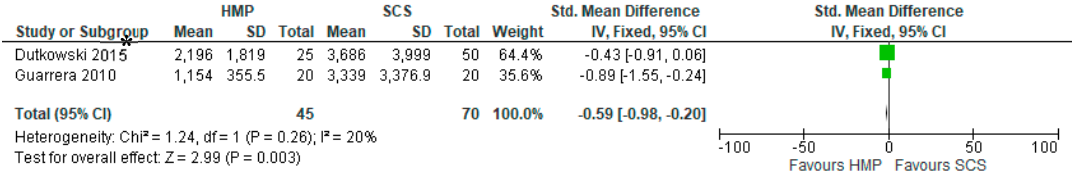
Figure 15. Peak serum AST in studies comparing HMP to SCS. In papers marked with “ * ”, mean and standard deviation were calculated using the method described by Wan 2014 [5].